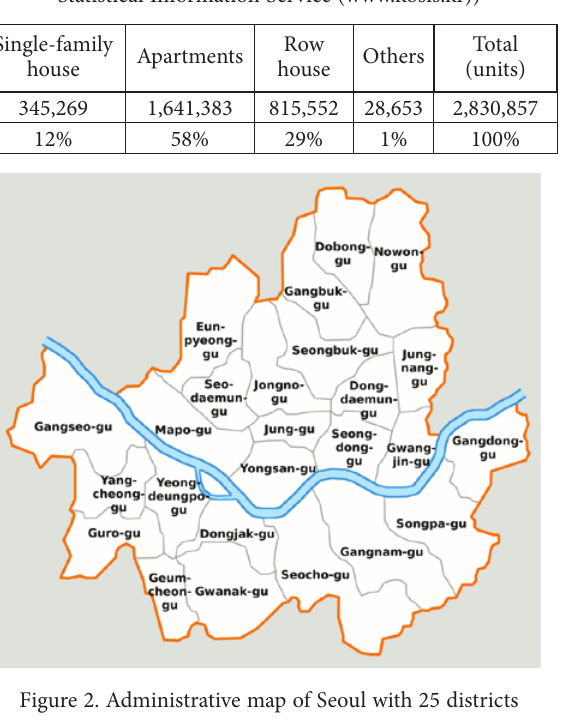
Table 1. Housing stocks in Seoul (2016) (source: Korean Statistical Information Service (www.kosis.kr))